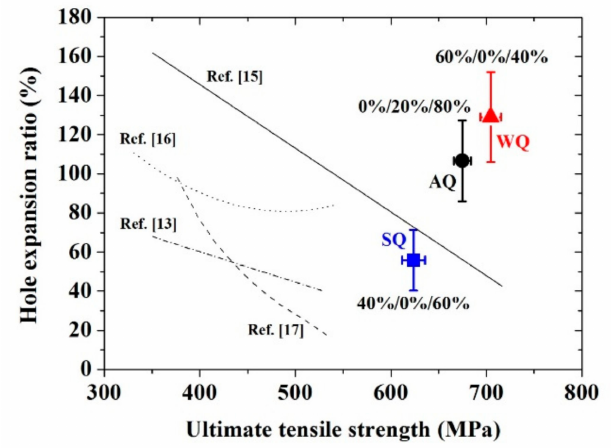
Figure 3. HER–UTS relation of DP steels in the present study as well as the literature. The number in percent indicates the probability of through-thickness crack formed along RD, 45 ◦ to RD, and TD,